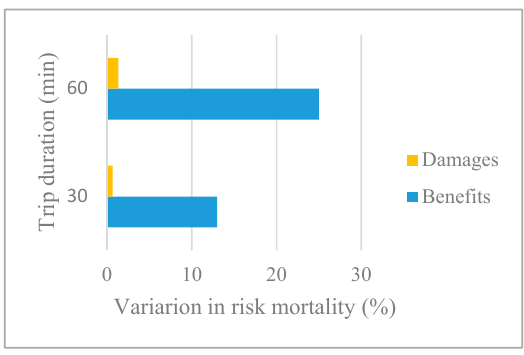
Figure 5. Variation in mortality risk for different trip durations under the 2024 scenario conditions.